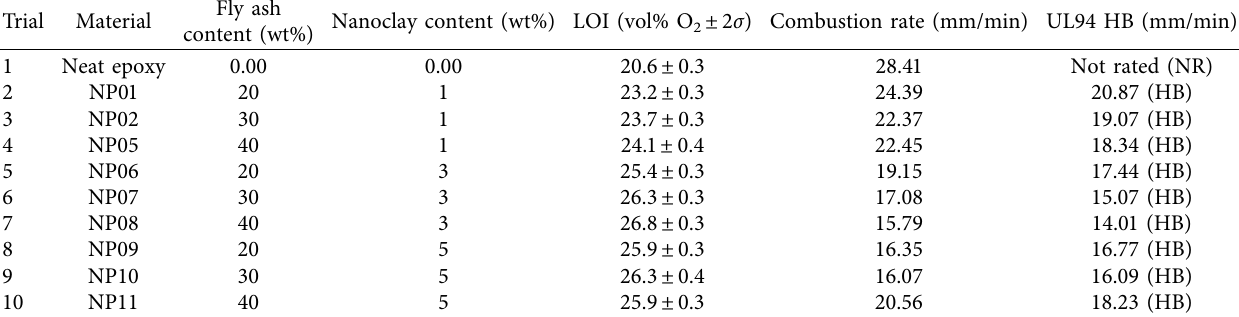
Table 9: Results for flammability tests (reaction to small flame) oxygen index (OI) and UL 94 for fly ash/nanoclay/epoxy nanocomposites. Fly Trial Material